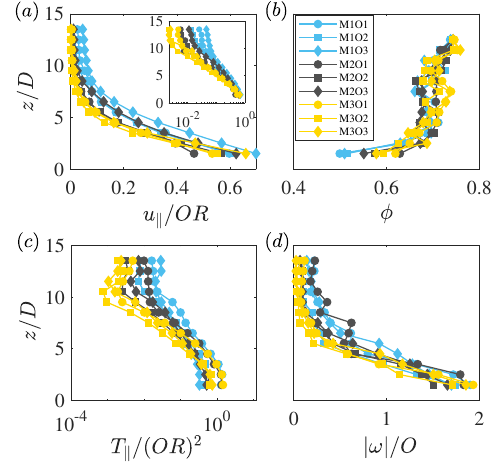
Figure 3. Depth profile for scaled ( a ) streamwise velocity, ( b ) volume fraction, ( c ) streamwise granular temperature and ( d ) an- gular